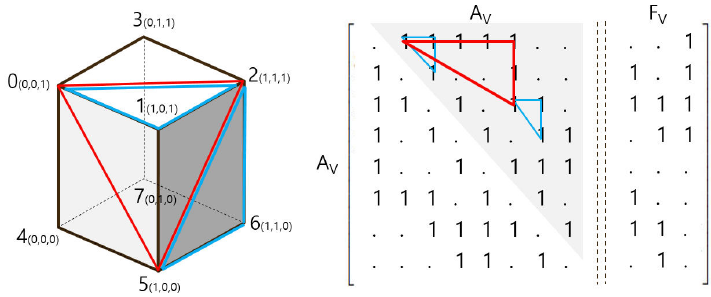
Figure 9. Reconstruction error of vertex adjacency ( A V )